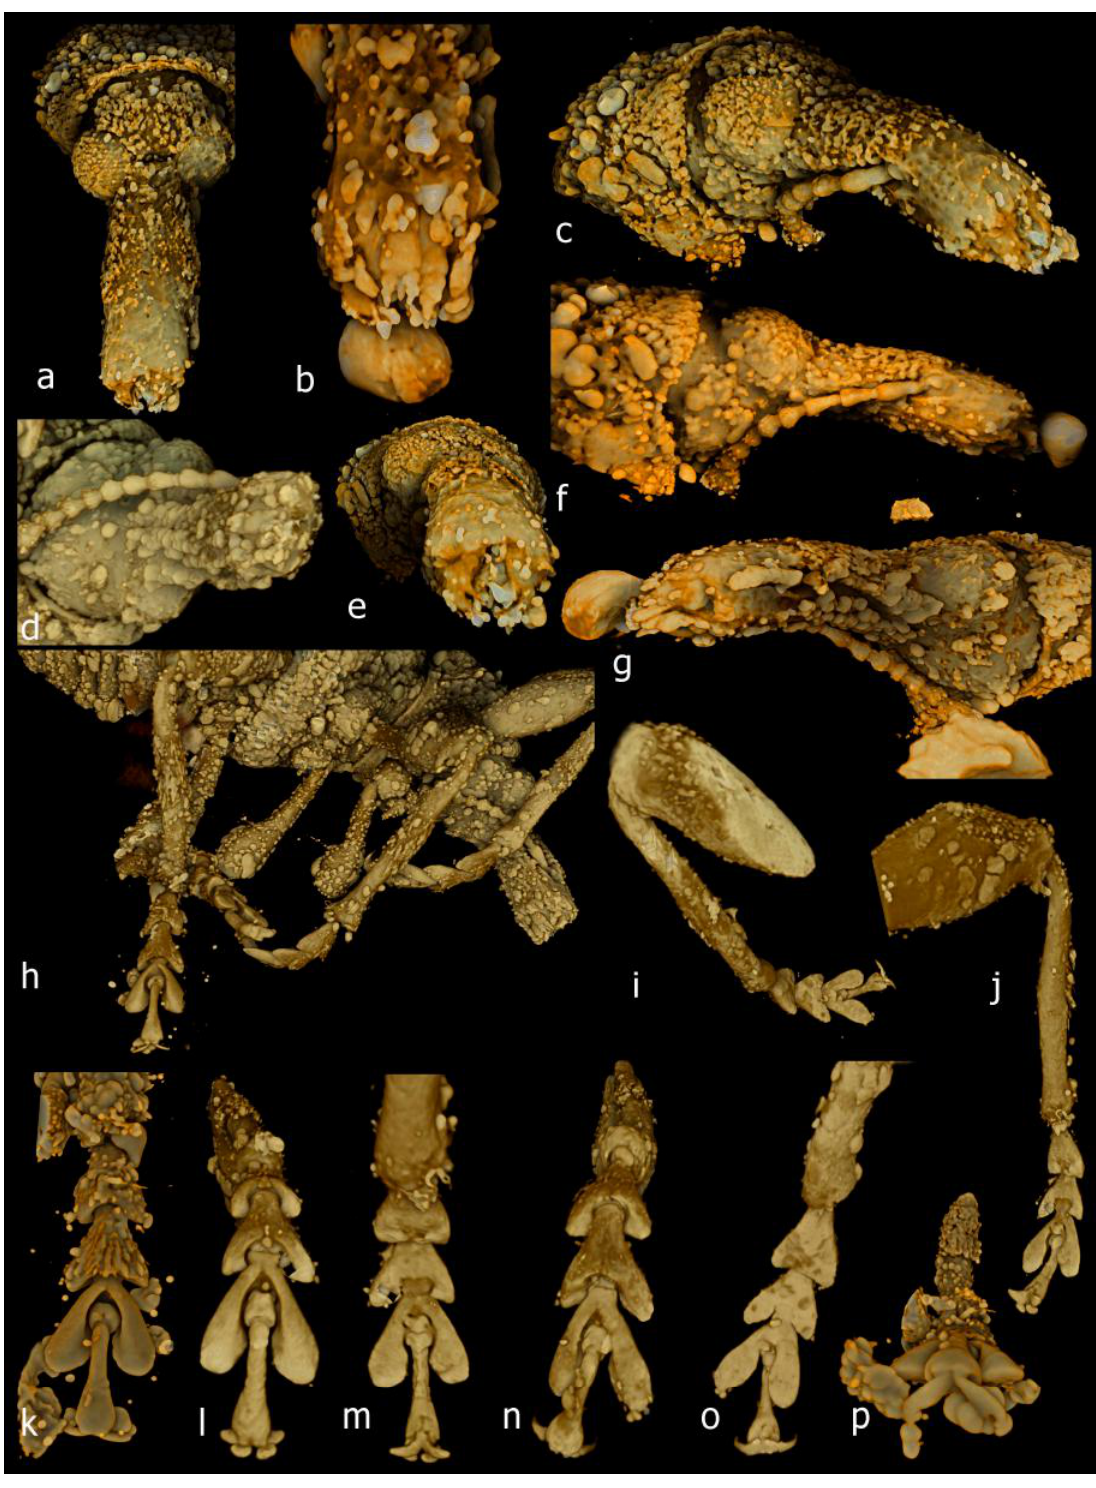
Figure 24. Calyptocis brevirostris sp. n., holotype. Morphological details extracted from micro-CT scanning reconstruction (see also Video S1). Head, dorsal ( a ); apical part of rostrum and mouthparts, ventral ( b ); head, right lateral oblique ( c ); head, ventral ( d ); head, frontal oblique ( e ); head, right lateral ( f ); head left lateral ( g ); head, thorax and legs, ventral oblique ( h ); legs ( i,j ); tarsi ( k–p ).